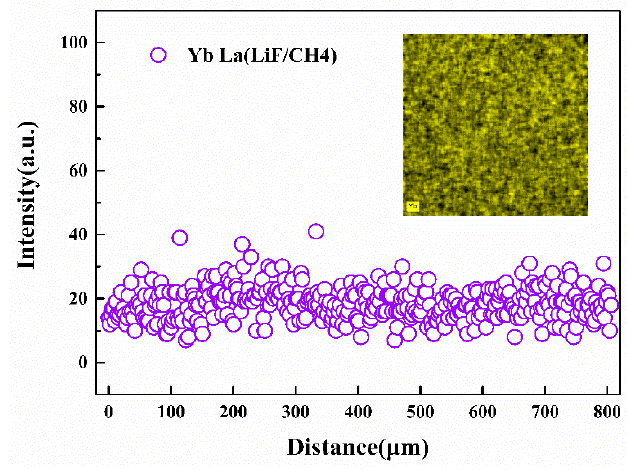
Figure 7. The axial and radial (inset) distributions of Yb 3+ in the LuAG fiber.